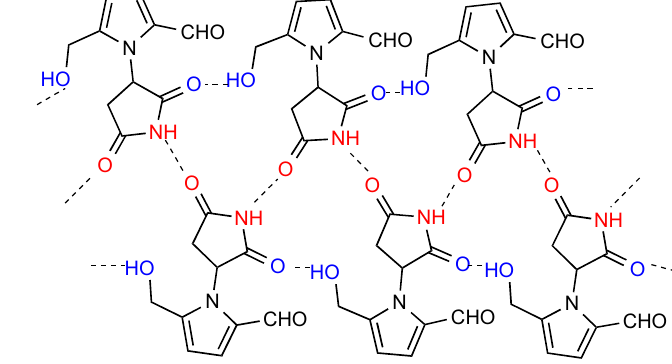
Figure 16. Structure observed for compound 43.